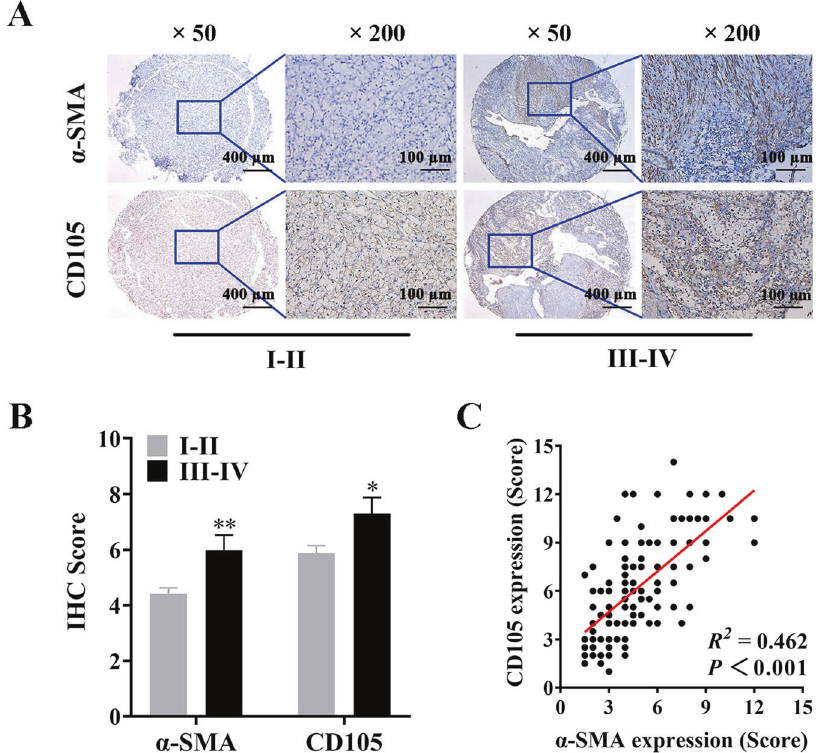
Fig. 1 The enrichment of CAFs is associated with tumor progression and cancer stemness in RCC. A Representative images of IHC staining of α -SMA and CD105 in RCC tissues ( n = 141). B IHC score of α -SMA and CD105 in low stage (I – II) ( n = 111) and high stage (III – IV) ( n = 30), the data are shown as the mean ± SEM; C Pearson ’ s correlation scatter plot of IHC score of α -SMA and CD105 ( n = 141). P value between two groups was obtained by Unpaired t test. * P < 0.05; ** P <